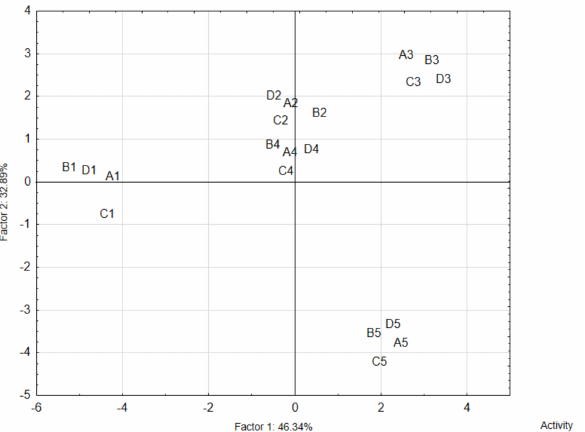
Figure 2. Principal component analysis (PCA) plots of data from overall desirability of extruded snacks with the addition of fermented red or broad bean seeds/hull and with herbs/species (0.5%), and without the addition of herbs/spices (Control); Addition of ground fermented red bean seeds (A): Control 1A, Thyme 2A, Oregano 3A, Basil 4A, Lovage 5A; Addition of fermented red bean hull (B): Control 1B, Thyme 2B, Oregano 3B, Basil 4B, Lovage 5B; Addition of ground fermented broad bean seeds (C): Control 1C, Thyme 2C, Oregano 3C, Basil 4C, Lovage 5C; Addition of fermented broad bean hull (D): Control 1D, Thyme 2D, Oregano 3D, Basil 4D; Lovage